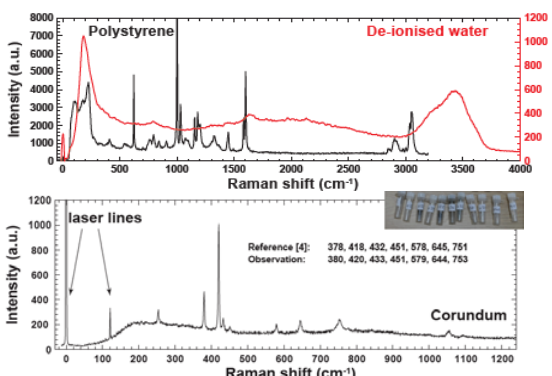
Figure.5. Raman spectrums of: a) polystyrene and de-ionized water and b) corundum (Al